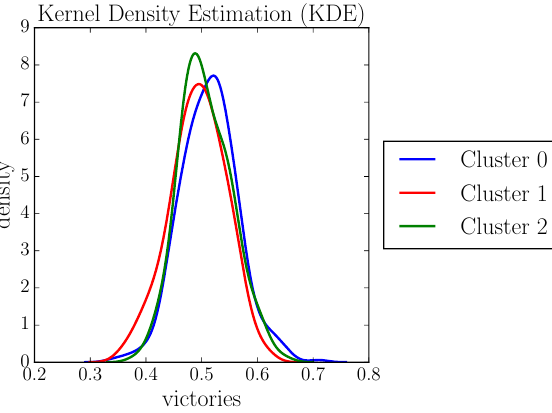
Figure 7. Kernel Density Estimation (KDE) computed on the values related to the feature winner (binary feature equal to 1 if a player wins the match and equal to 0 if a player loses). The figure shows the probability density function for each cluster. We maintained the color code used throughout the text to discriminate the different